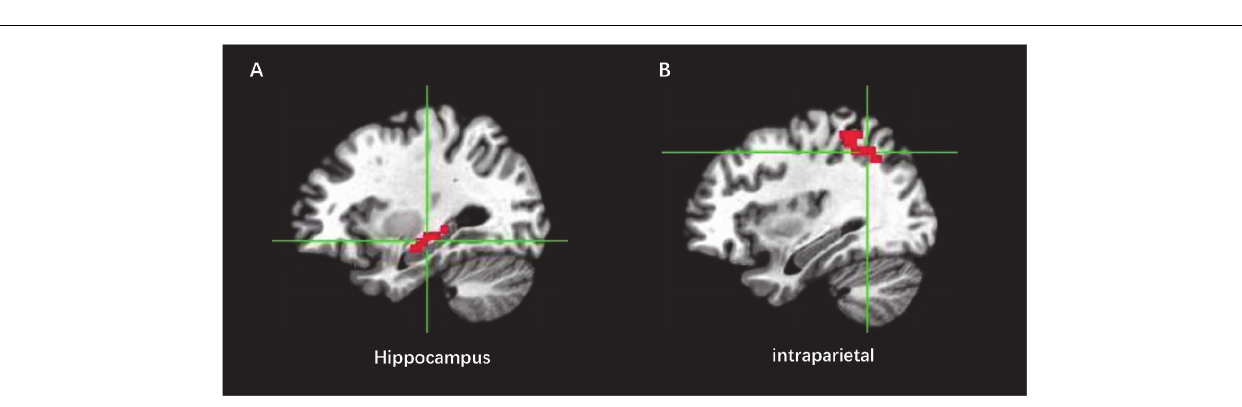
FIGURE 3 | Experimental procedure in the run. The experiment consists of four runs each lasting for 6 min 20 s each, and each run contains five blocks. During the feedback run, participants experience rt-fMRI NF training consisting of alternating blocks of view, feedback, and count (instructed to count backward from 300 by a given integer). During the “feedback” blocks, they are asked to apply a recall strategy with positive AMs to regulate the ROI activity. The feedback value is computed based on ROI activation.